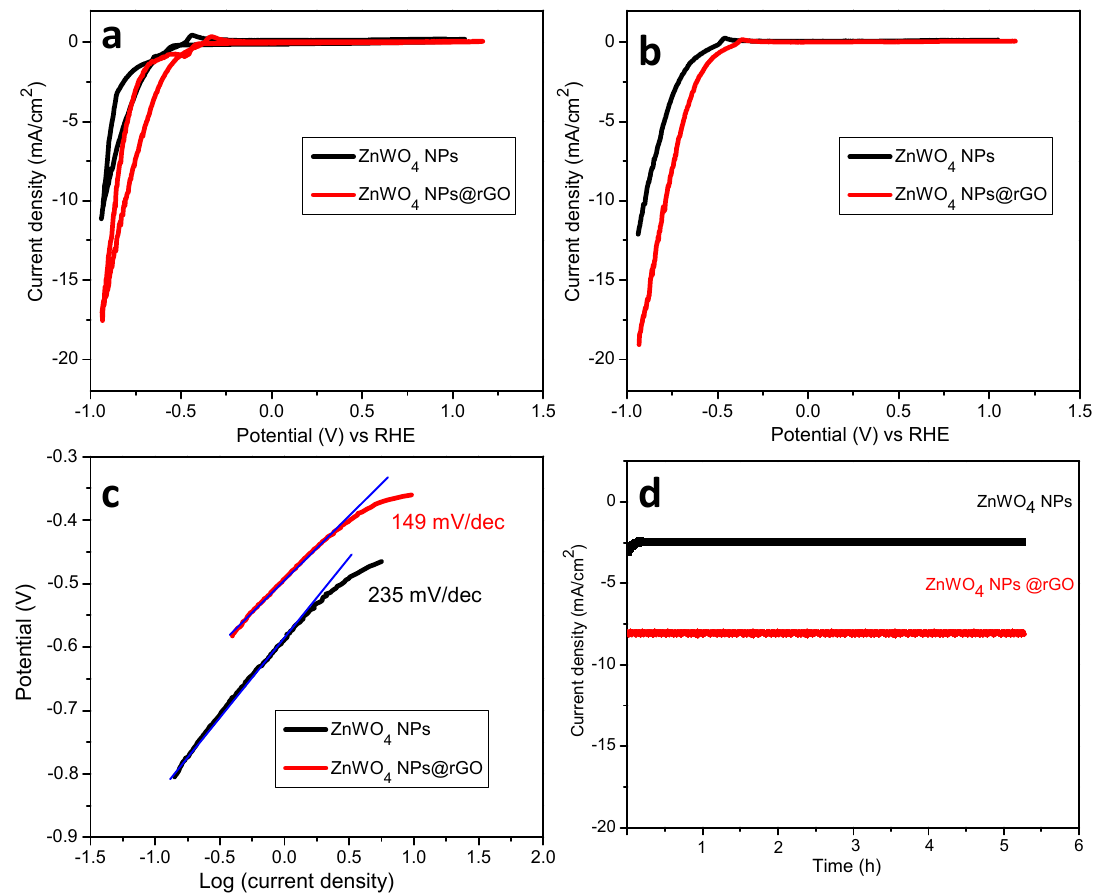
Figure 4. ( a ) CV, ( b ) LSV, ( c ) Tafel, and ( d ) CA curves of ZnWO 4 − NPs@rGO nanocomposites and pure ZnWO 4 − NPs for HER in 0.5 M KOH.